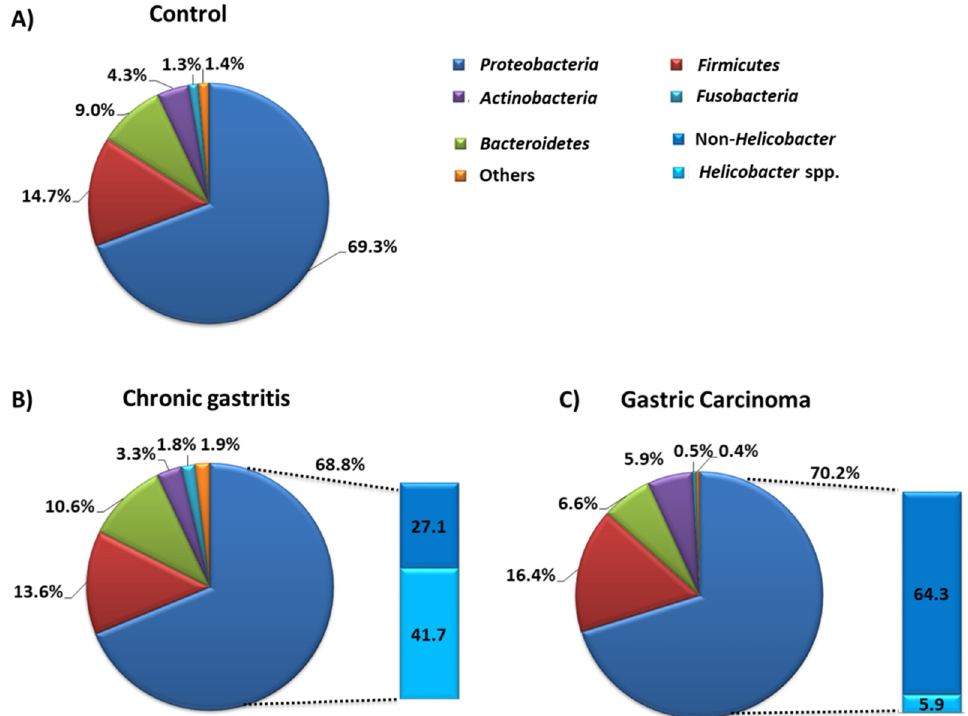
Figure 6. Composition of stomach microbiota in the state of dysbiosis and under the control con- ditions. ( A ) Composition of stomach microbiota in control group of patients. ( B ) Composition of stomach microbiota in chronic gastritis. ( C ) Composition of stomach microbiota in gastric carcinoma (based on [88]).